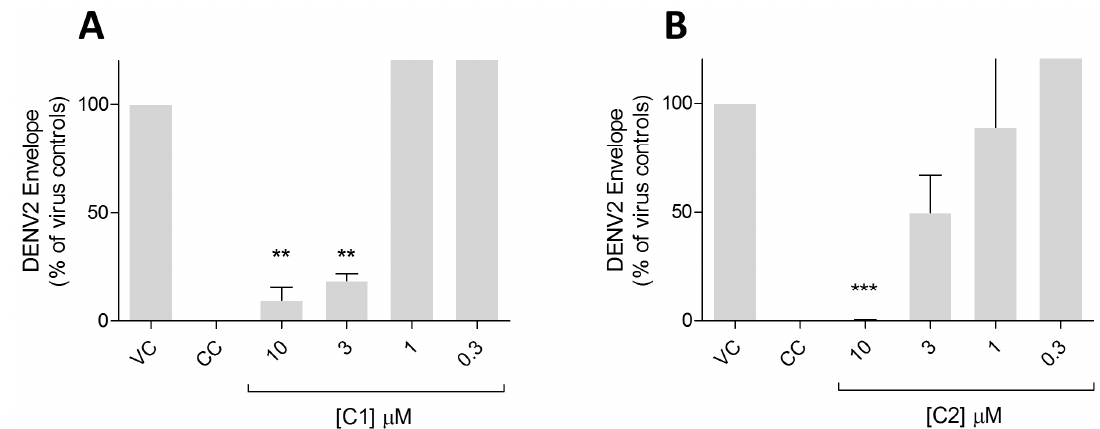
Figure 3. Reduction of viral envelope glycoprotein accumulation in Vero cells infected and treated with compounds 1 (panel A ) or 2 (panel B ) or vehicle (DMSO). Cell lysates at 48 h post infection were assayed with Western blot as described in Materials and Methods. The intensity signals were detected using chemiluminescence and normalized to the signal of the loading control at each lane. The normalized value for envelope protein in nontreated, dengue-infected cultures was considered as 100%. VC, virus control, corresponding to infected, non treated cells. CC, cell control, corresponding to non treated, non infected cells. Data is expressed as mean ± standard error of three independent experiments. Statistically different means from the value of the virus control sample are marked as (**) p < 0.01 or (***) p < 0.001.